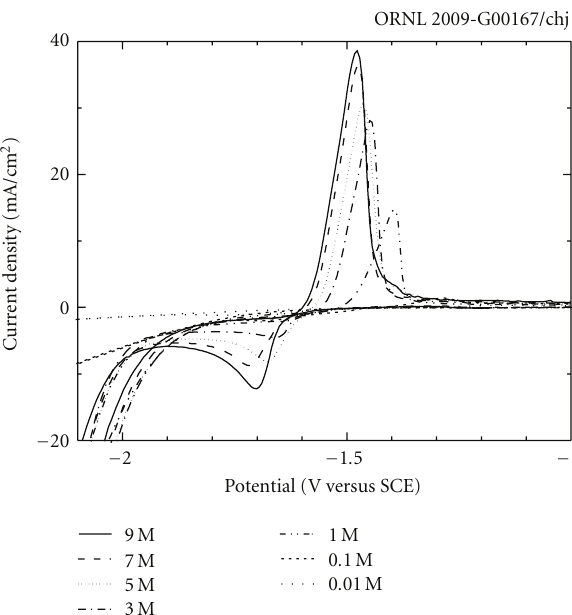
Figure 3: Current versus applied potential behavior of ZnO single- crystal electrode sample 4 as a function of the NaOH concentration in the electrolyte.